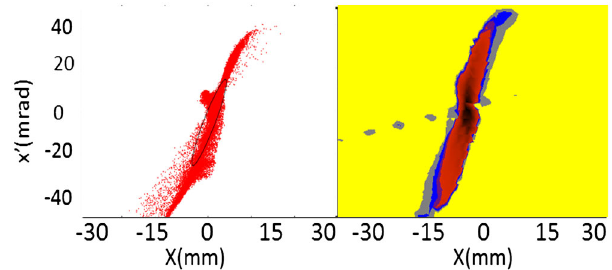
FIG. 16. Phase space picture simulation (left) and measurement (right) for krypton.